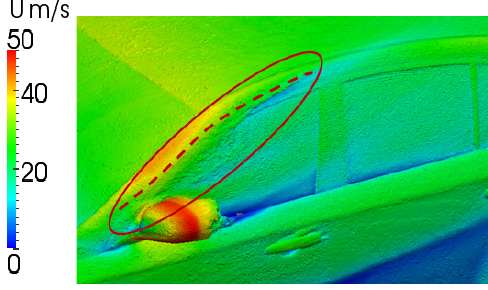
Figure 12. Velocity distribution on the side window obtained using the SLM method at t = 0.765 s.